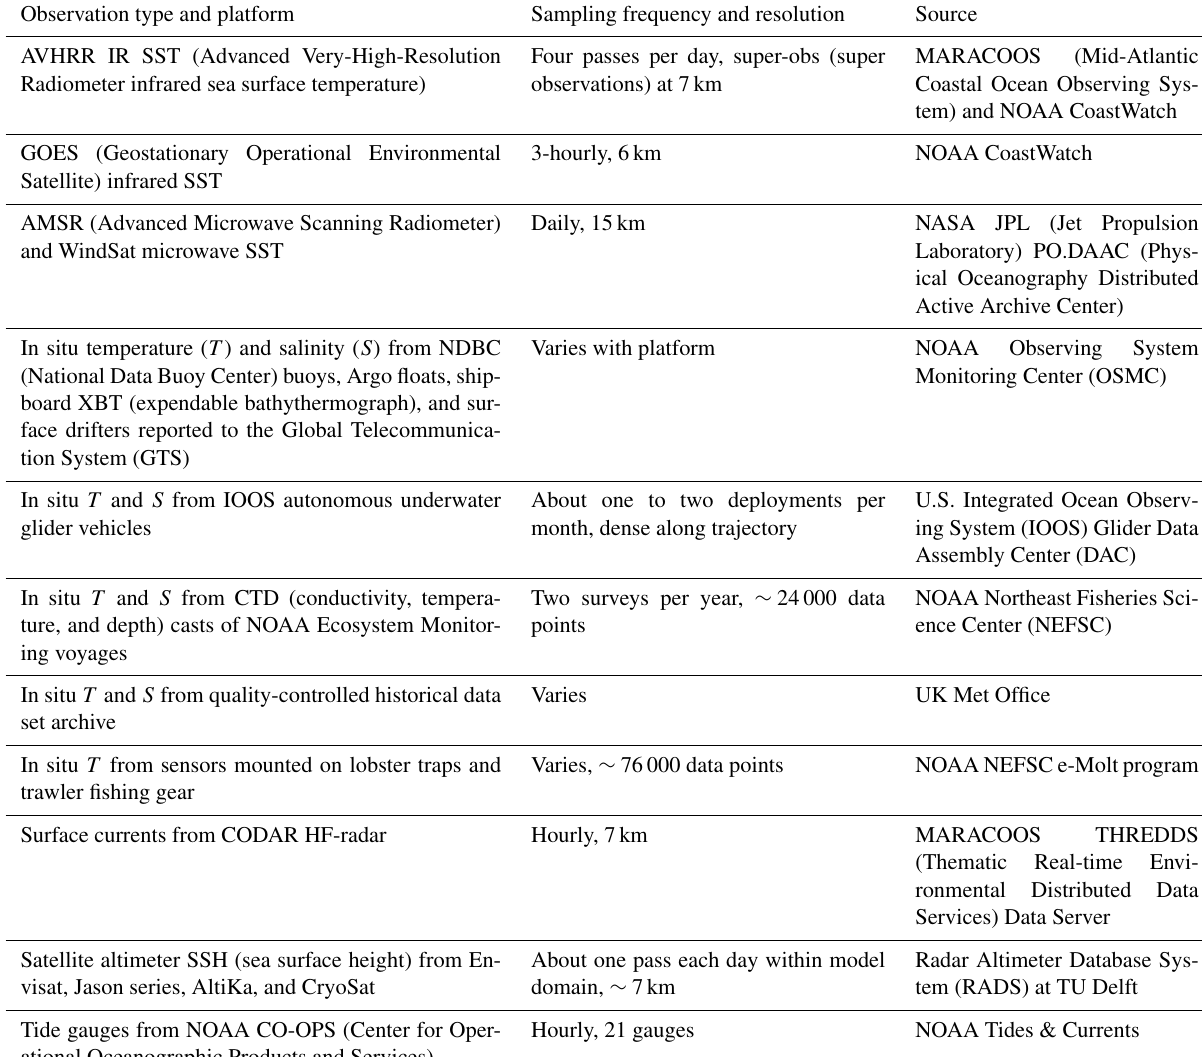
Table 2. Observations used in model-data skill assessment, their nominal resolution, and origin. Observation type and